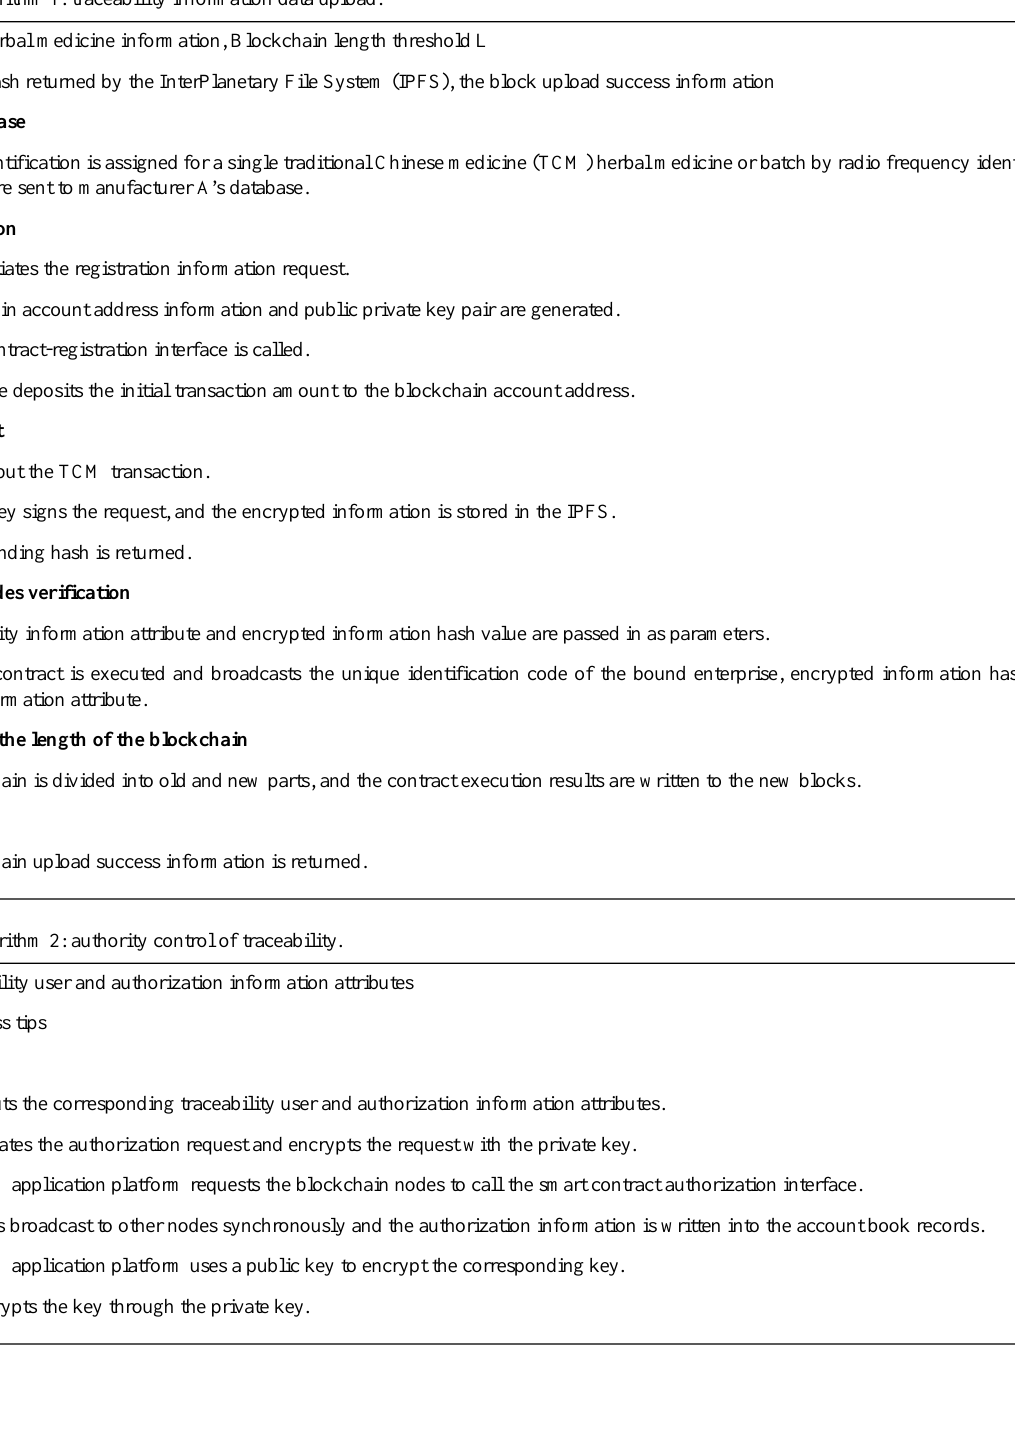
Textbox 1. Algorithm 1: traceability information data